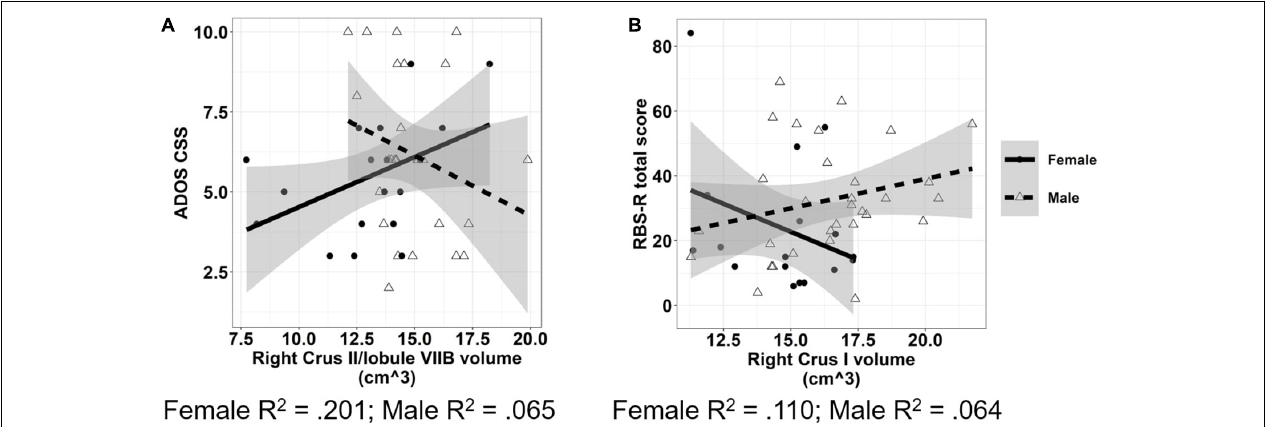
FIGURE 7 | Associations between cerebellar volumes and ASD symptom severity which vary across males and females. Increased volume of cerebellar right Crus II/lobule VIIB (A) was associated with reduced ASD symptom severity in males, but not females. Increased volume of cerebellar right Crus I (B) was associated with reduced severity of RRBs in females, but not males. The shaded region reflects the 95% confidence interval of a linear fit. R 2 values reflect the proportion of variance in clinical symptoms accounted for by cerebellar ROI volume in a one-term model. ADOS CSS, Autism Diagnostic Observation Schedule Calibrated Severity Score; RBS-R, Repetitive Behaviors